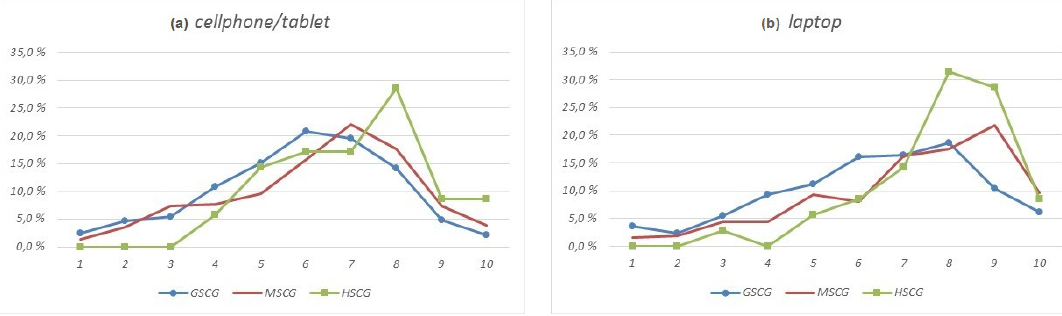
Figure 6. On a scale from 1 (none) to 10 (excellent), how do you assess your knowledge of issues and risks associated with the use of your—( a ) cellphone/tablet, ( b ) laptop?